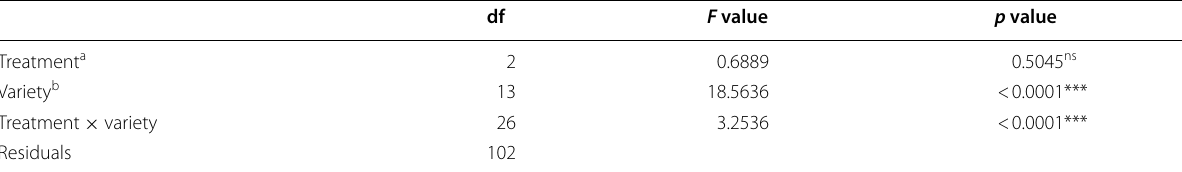
a N0, N50, N200 b TN1, IR24, NIL- BPH4 , NIL- BPH9 , NIL- BPH10 , NIL- BPH17 , NIL- BPH18 , NIL- BPH20 , NIL- BPH21 , NIL- BPH26 , NIL- BPH32 , NIL- BPH2 ns no significance, *** p value <